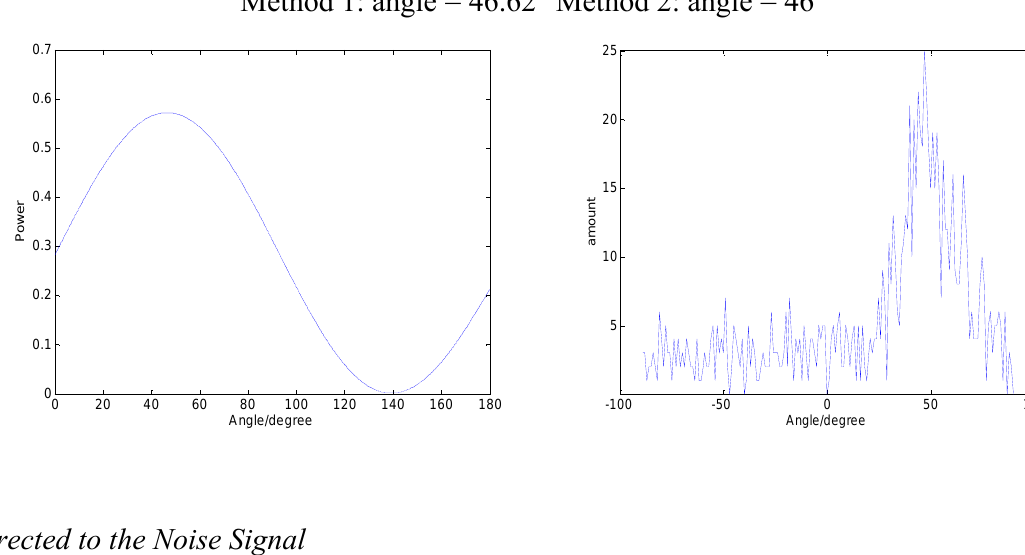
Figure 11. The results of the two methods (DOA = 45°).